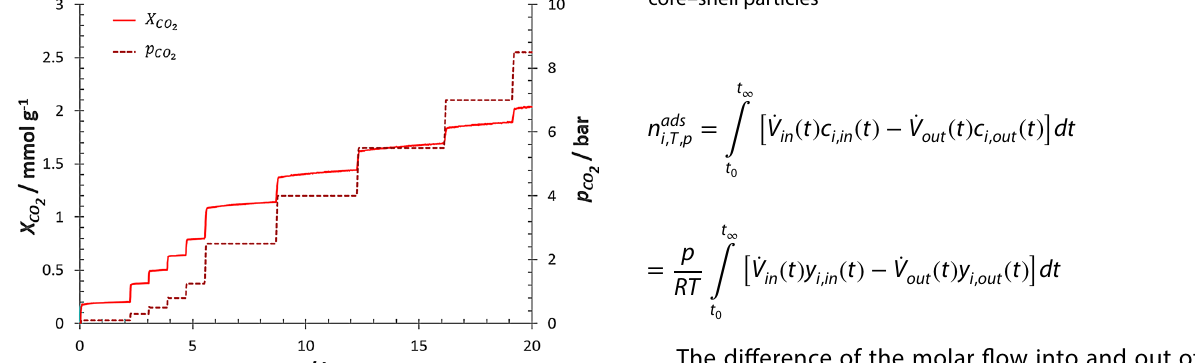
/CO -mixture ( y CO 4 2 2 O 2 3